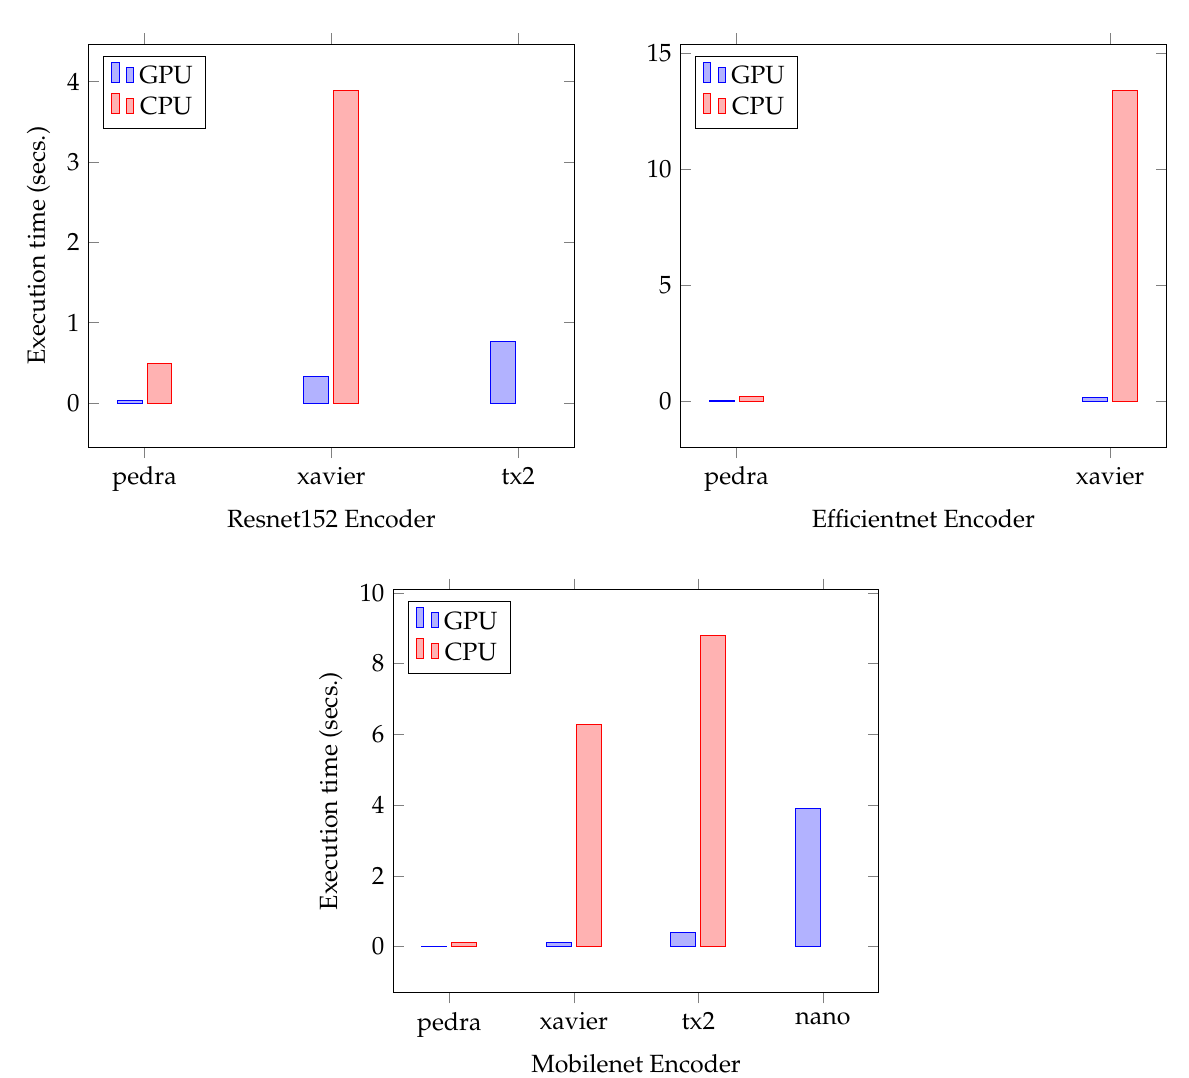
Figure 12. Unet architecture inference time comparative with all encoders. Figure 13 follows the same structure as in Figure 11, but showing the DeeplabV3 execution times with all encoders. The big difference is that this model could not be run on the Jetson Nano device with any encoder. In ResNet152 it can be seen how, in the TX2 platform in the CPU, the time is very high with respect to Xavier, achieving a GPU time of less than 1 s. In EfficientNet, the execution times are significantly higher than in ResNet152, and it was not possible to perform the execution of the TX2 platform in the CPU due to lack of memory. Using MobileNet, the fastest execution times are achieved within the TX2 device, but not for